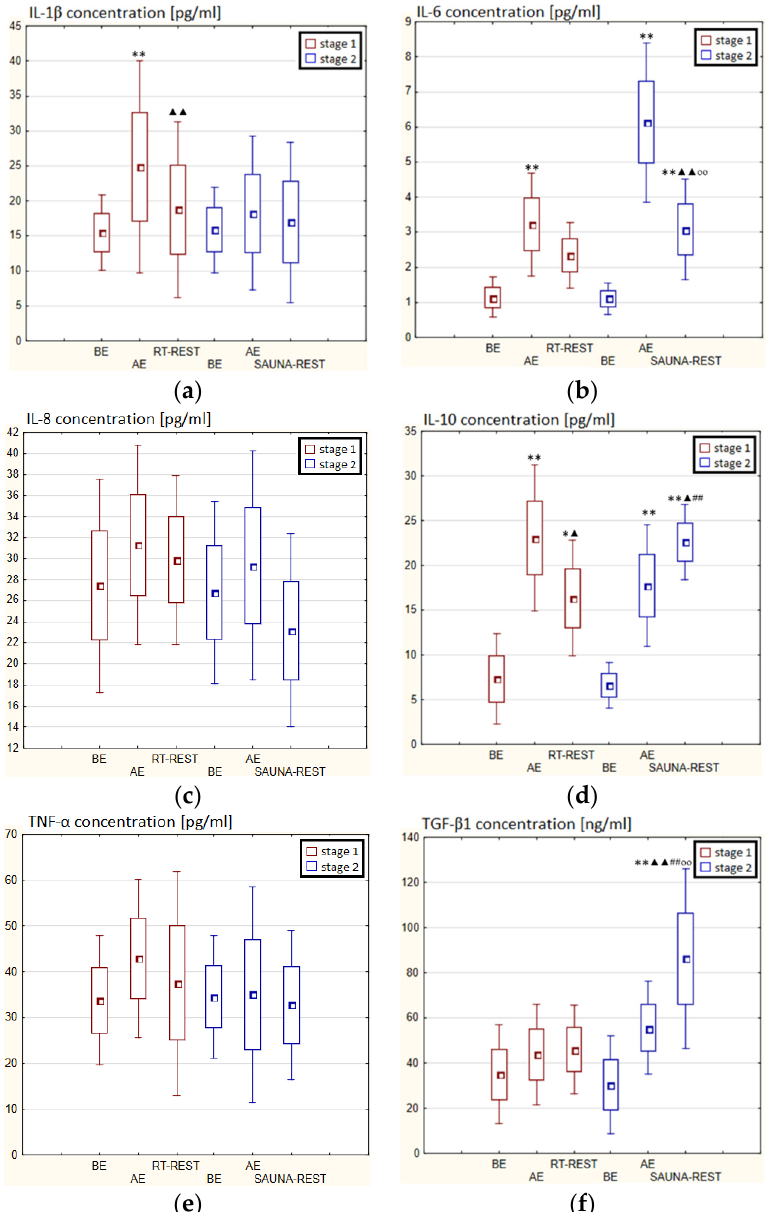
Figure 7. The concentration of selected cytokines in blood serum of winter swimmers ( n = 22) in Experiment II: ( a ) IL-1 β concentration; ( b ) IL-6 concentration; ( c ) IL-8 concentration; ( d ) IL-10 concentration; ( e ) TNF- α concentration; ( f ) TGF- β 1 concentration. Data are presented as the mean values ± SD. IL-1 β —interleukin 1 β , IL-6—interleukin 6, IL-8—interleukin 8, IL-10—interleukin 10, TNF- α —tumor necrosis factor α , TGF- β 1—transforming growth factor β 1, BE—before exercise, AF—after exercise, RT-REST—20-min recovery at room temperature, SAUNA-REST—rest combined with sauna bath, * p < 0.05 vs. BE, ** p < 0.001 vs. BE, ▲ p < 0.05 vs. AE, ▲▲ p < 0.001 vs. AE, ## p < 0.001 vs. RT-REST, oo p < 0.001 vs. CWI-REST.